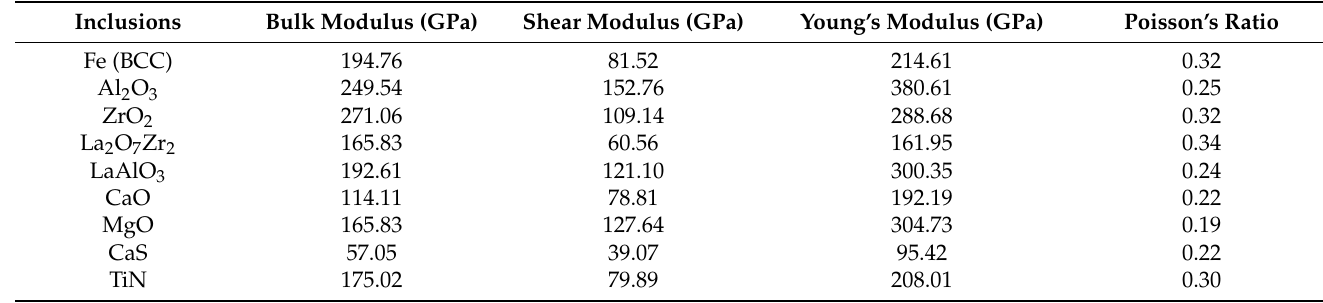
Table 6. Calculated mechanical properties of the inclusions and Fe